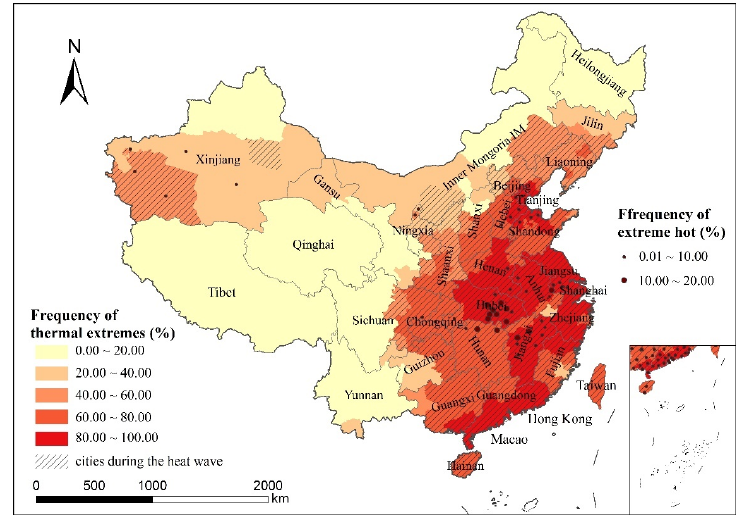
Figure 9. Frequency distribution of thermal extreme comfort levels during heat waves (shaded areas are cities during the heat wave).